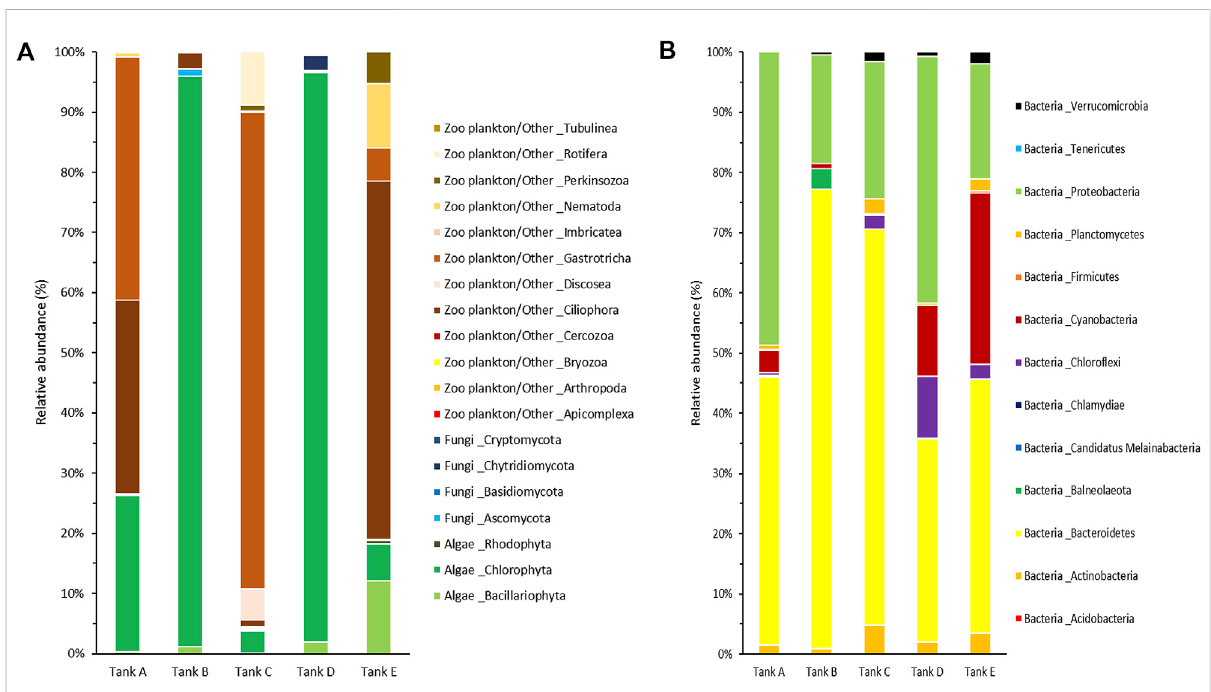
FIGURE 4 Community composition at the phylum level from the fi ve tanks. (A) The eukaryotic and (B) prokaryotic microbial communities are indicated separately. The data underlying all the graphs indicated in this fi gure can be found in Table 2 and Supplementary Tables S1,